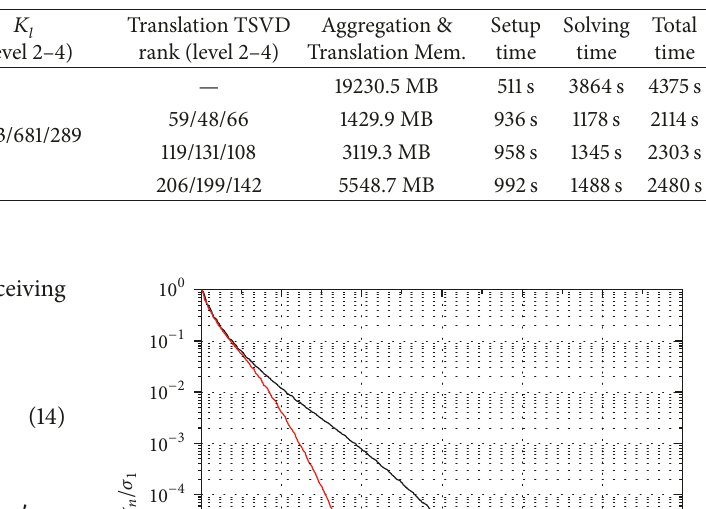
Table 1: Computational statistics.